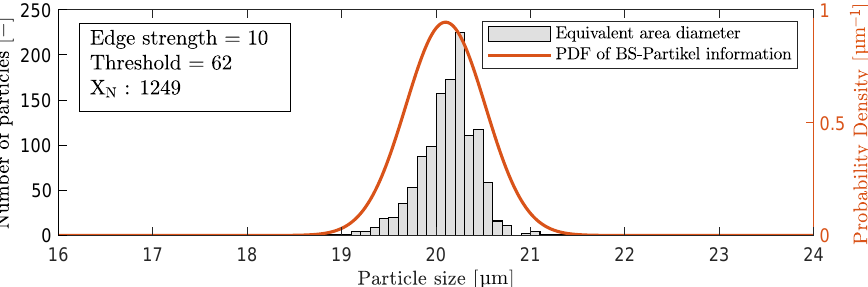
visualize the performance of estimating the particle sizes.